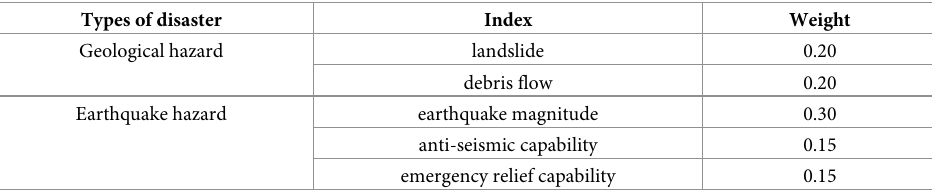
Table 5. Risk assessment system of natural disaster